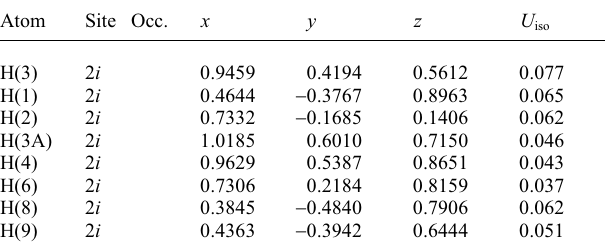
Table 2. Atomic coordinates and displacement parameters (in Å 2 )